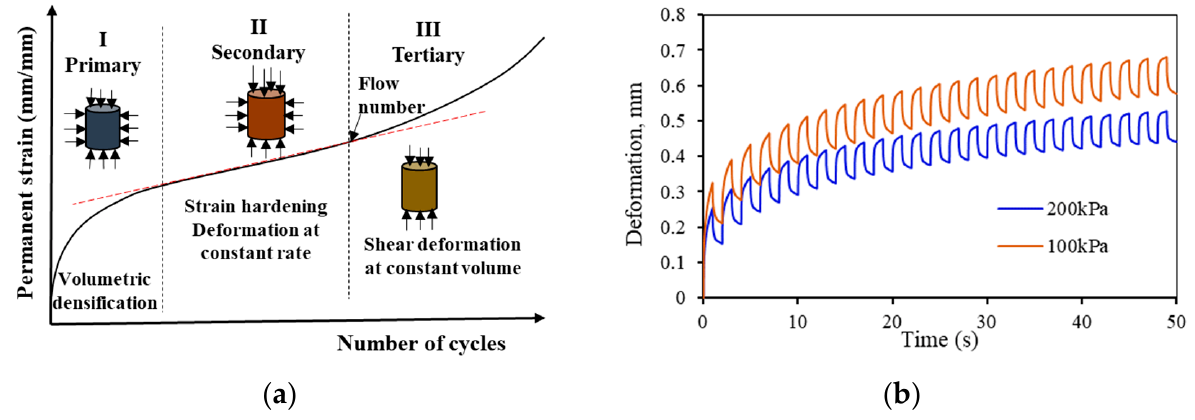
Figure 2. ( a ) Schematic three-stage creep deformation and ( b ) example of a creep-recovery test result at different confining pressures (100 kPa and 200 kPa).